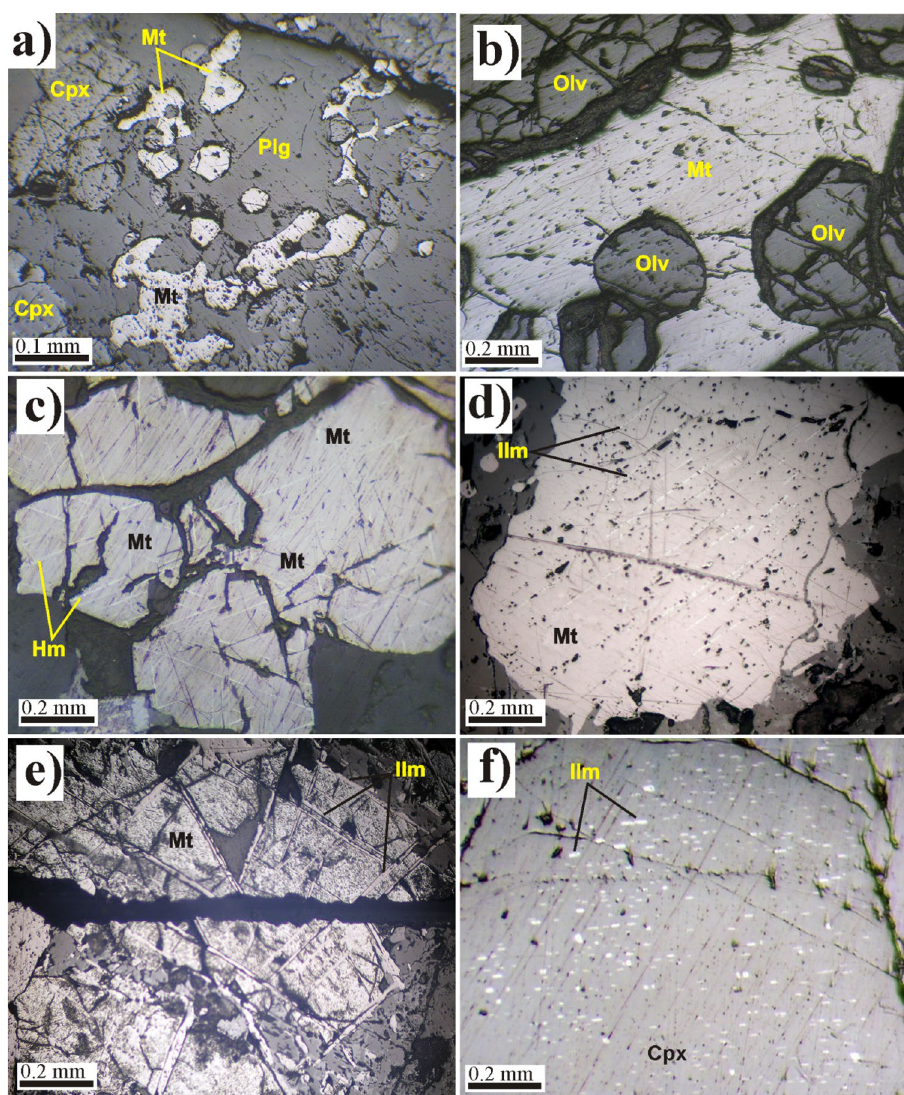
Figure 2. Photomicrographs of Fe–Ti oxides-rich mafic-rocks from the Akab El-Negum area. ( a ) Cumulus magnetite hosted in large plagioclase crystal, disseminated ore in pyroxene gabbro, ( b ) Intercumulus magnetite hosting cumulus olivine, semi-massive ore in pyroxene gabbro, ( c ) Magnetite slightly altered to hematite along octahedral planes, semi-massive ore in pyroxene gabbro, ( d ) Parallel ilmenite bands intergrown in large magnetite grain, semi-massive ore in olivine-gabbros, ( e ) Ilmenite bands arranged along the octahedral planes of magnetite forming trellis intergrowth, semi-massive ore in pyroxene gabbro, and ( f ) Ilmenite rods or fine needles arranged along Cpx cleavage planes, semi-massive ore in troctolite. All photos were taken under reflected